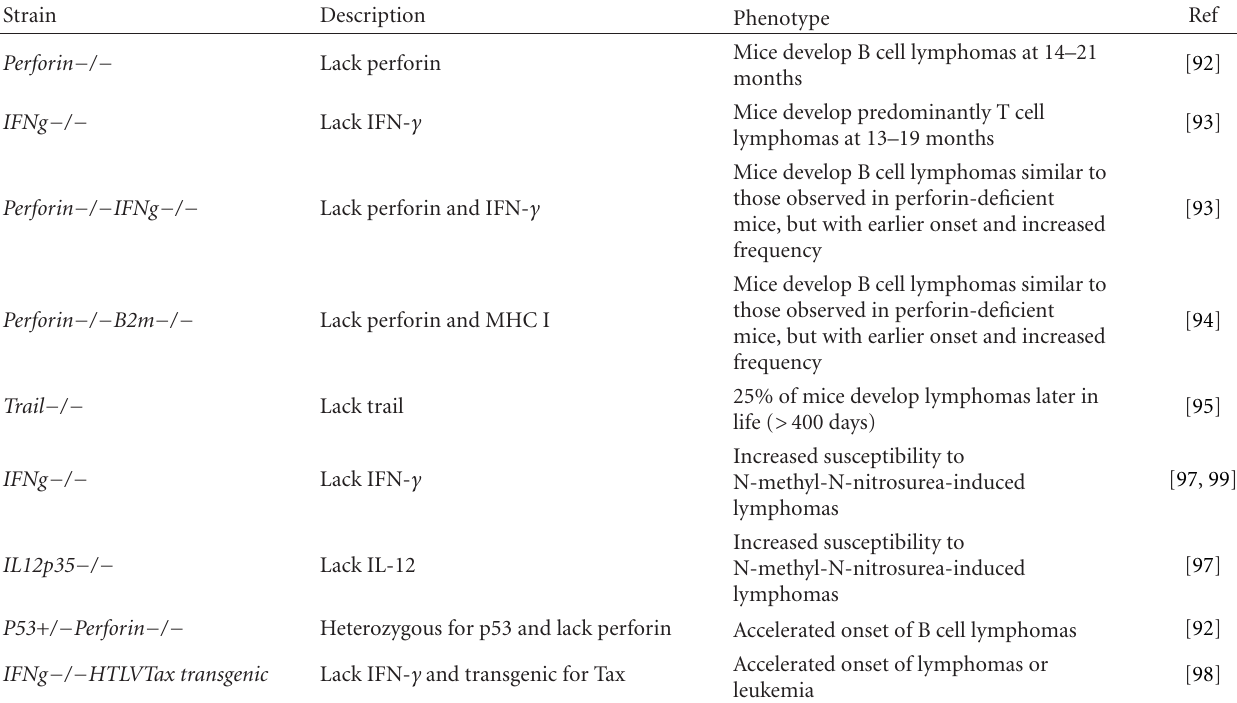
Table 1: Immunodeficient mouse strains that develop spontaneous or induced